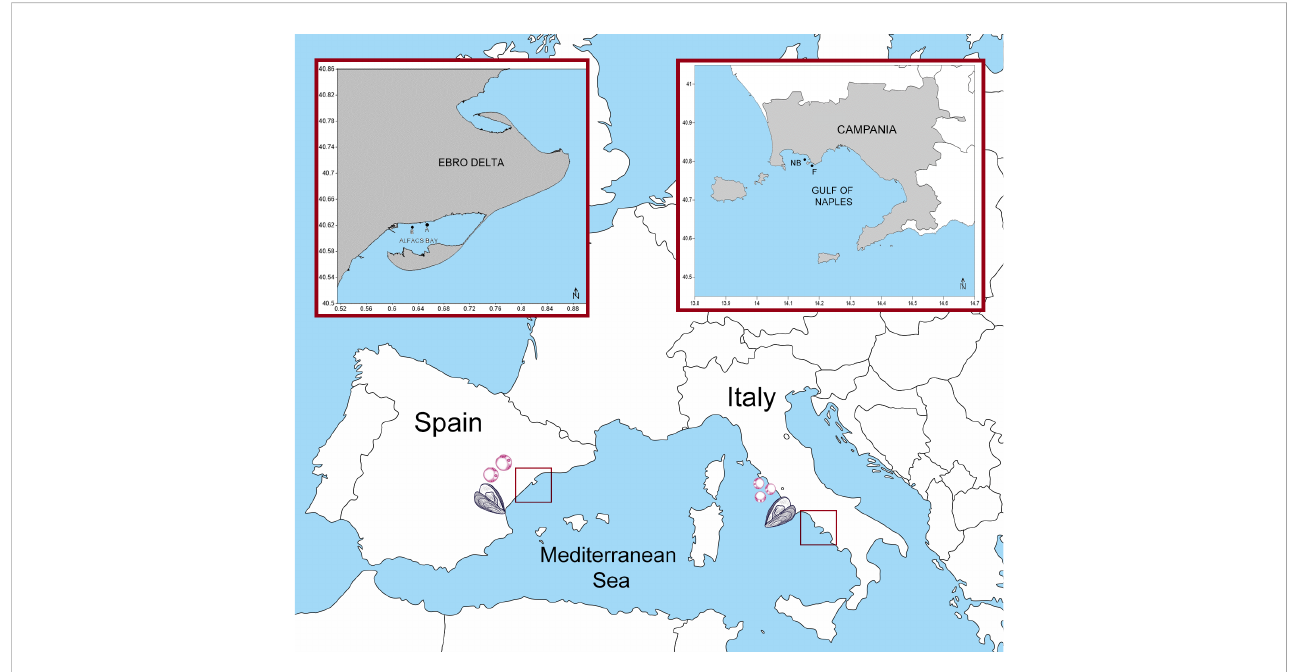
FIGURE 1 Locations of sampling areas in Italy and Spain: Bay of Naples and Bay of